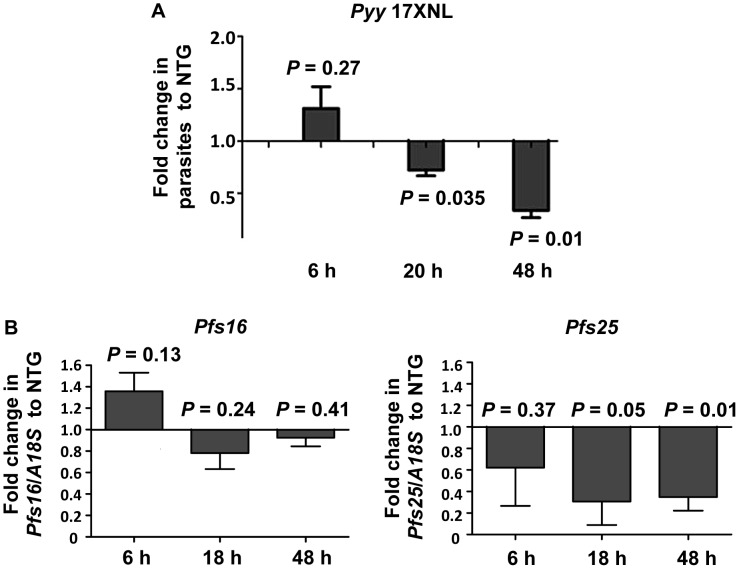
HM myrAkt An. stephensi exhibited enhanced killing of early stage GFP-Plasmodium yoelii yoelii 17XNL (Pyy 17XNL) and P. falciparum relative to NTG females.(A) Pyy 17XNL parasites were quantified in dissected midguts at 6, 20 and 48 h post-infection by fluorescence detection (485 nm excitation/535 nm emission wavelengths). Significant killing was noted by 20 h post infection, when Pyy 17XNL are present as fully matured ookinetes in the midgut lumen and in transit across the midgut epithelium [76]. A secondary drop in infection levels was evident at 48 h, which coincides with early oocyst development for Pyy 17XNL [76]. (B) Plasmodium falciparum parasites were quantified using real-time reverse-transcriptase PCR of A18S rRNA (for total parasites) as well as Pfs16 and Pfs25, markers for sexual stage development [73], [74]. Changes in Pfs16 expression were not significant but trended downward relative to expression in NTG An. stephensi at 18 h and 48 h post-infection. A reduction in Pfs25 expression at 6 h suggested that early ookinetes were reduced in HM An. stephensi, with significant killing at 18 h post-infection, a time at which all ookinetes are still present in the midgut lumen [77]. A secondary significant drop was evident at 48 h, at which time ookinetes have traversed the midgut epithelium and are starting to transition to oocysts [77]. The data are represented as the average fold change ± SEM in the number of parasites for HM An. stephensi (black bars) compared to NTG An. stephensi at the same timepoints (indicated as the transition at 1.0). Data from independent experiments with three (A) or four (B) separate cohorts of An. stephensi females were analyzed by Student's t-test (alpha = 0.05) and P values are noted on the graph.